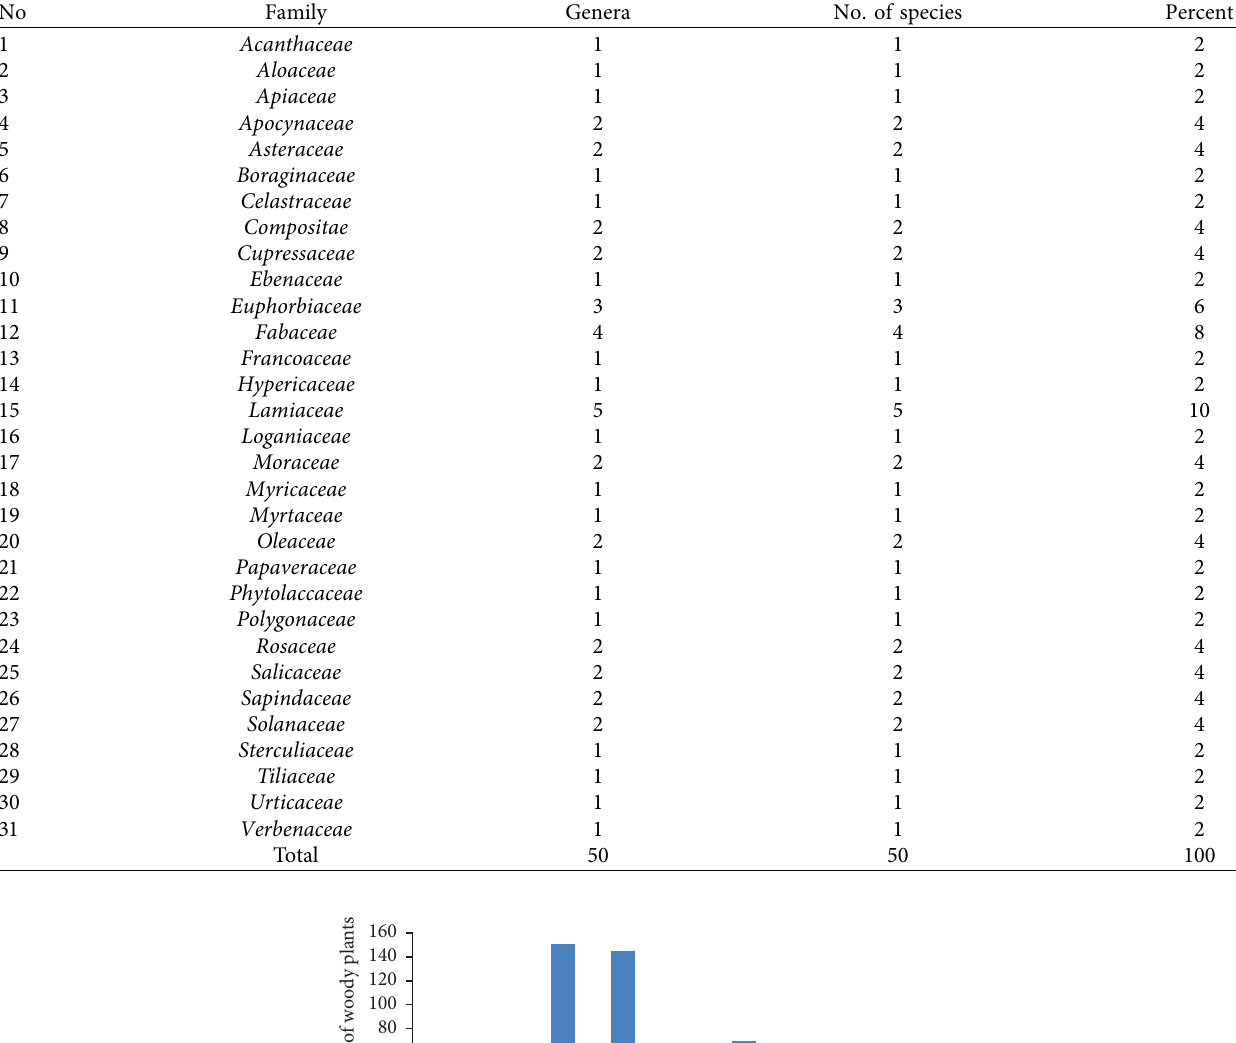
Table 2: List of woody plant families with their number of genera and species in Saleda Yohans church forest. No